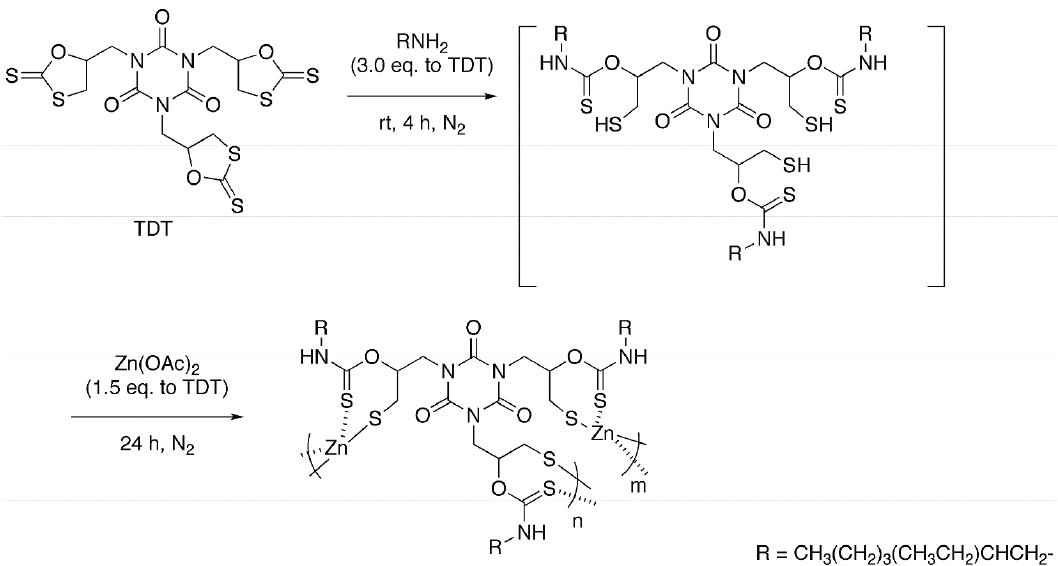
Scheme 1. One-pot synthesis of organic-sulfur-zinc hybrid via sequential ring-opening addition of EHA and TDT and polycondensation of the in situ generated thiol with Zn(OAc) 2 .